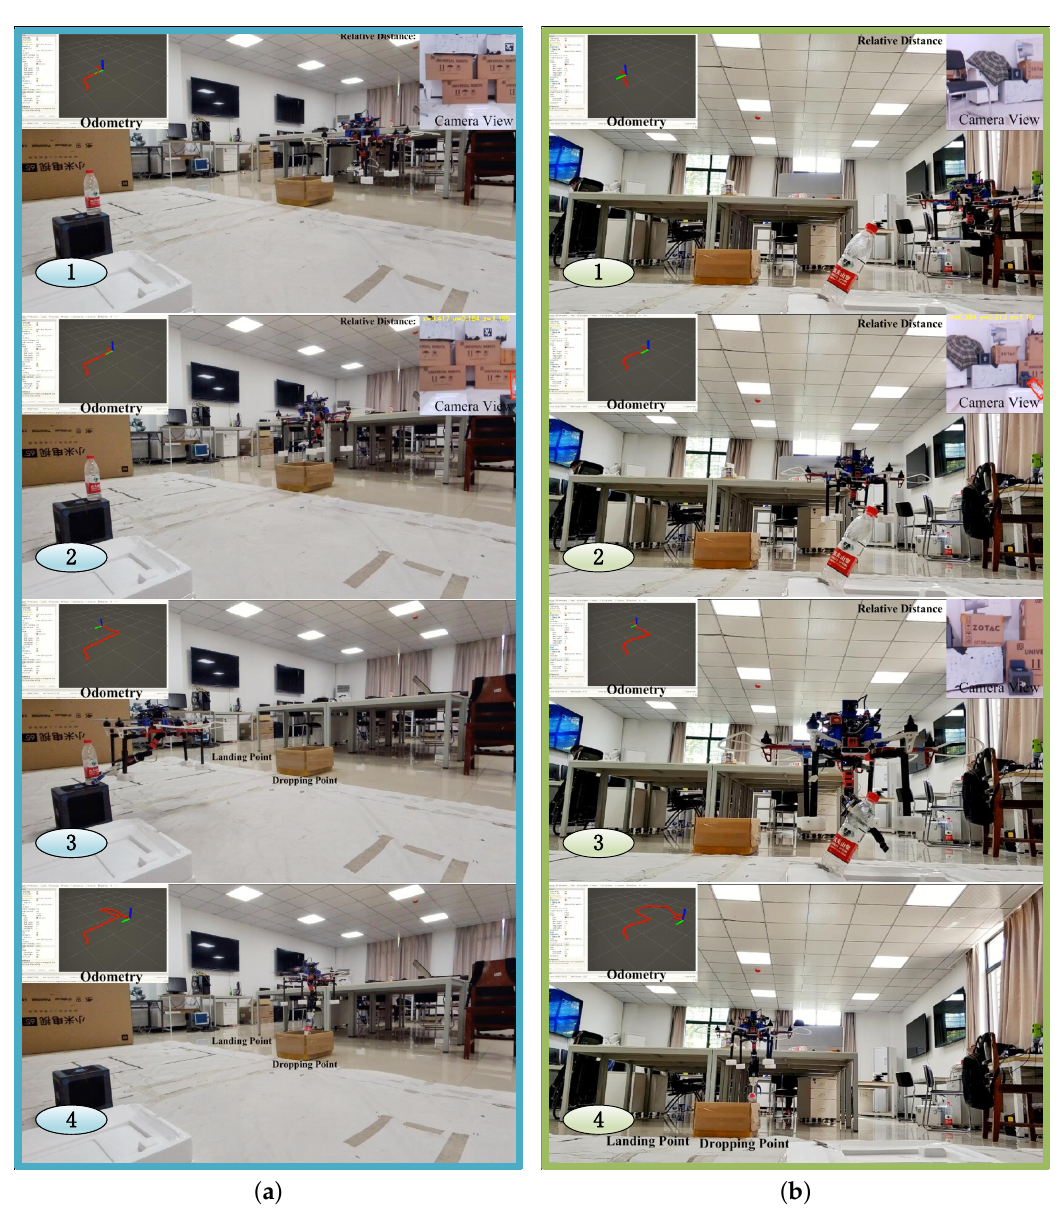
Figure 13. Snapshots of autonomous grasping experiments. The number in subfigures indicate selected moments: (cid:172) indicated the UAM is searching specific target; (cid:173) indicated the UAM detected the target and gives its relative position; (cid:174) indicated the UAM hovering at the grasping position, and the end effector is about to grasp the bottle. (cid:175) indicated the UAM dropping the grasped target at the dropping points. ( a ) Autonomous grasping of a bottle placed vertically; ( b ) autonomous grasping of a bottle placed